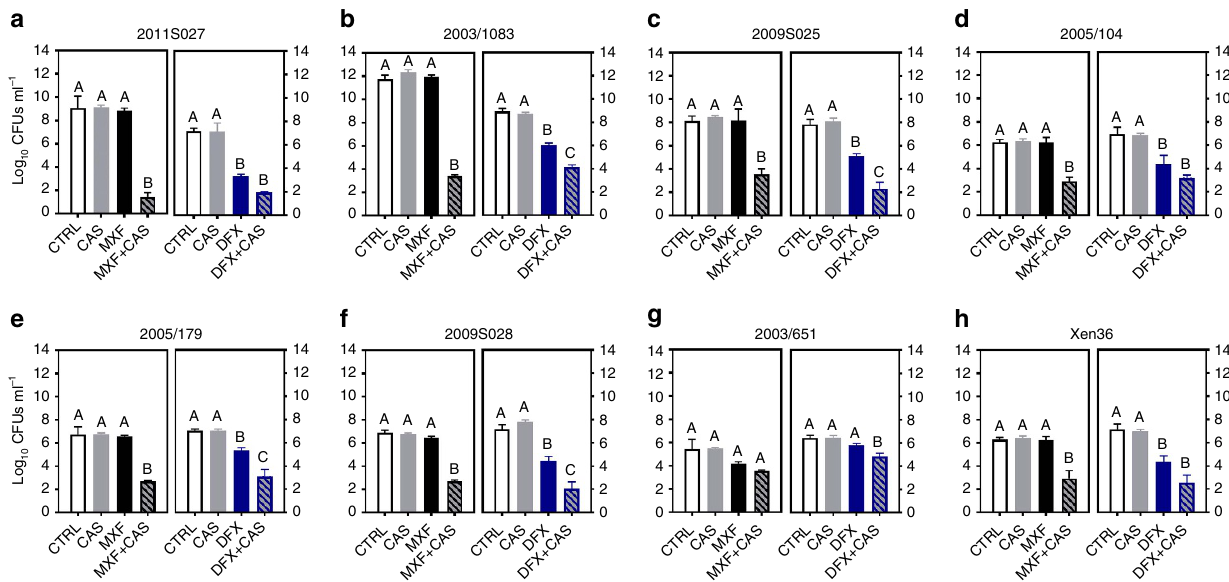
Figure 3 | Effect of caspofungin fluoroquinolones used alone or in combination on biofilms grown in catheters in vitro . Biofilms grown in catheters for clinical isolates ( a – g ) and the bioluminescent strain Xen36 ( h ) during 24h were exposed to caspofungin (CAS; 40mgl (cid:2) 1 ), fluoroquinolones alone (10mgl (cid:2) 1 ) or combined with 40mgl (cid:2) 1 CAS. In each graph, the left panel shows data obtained with moxifloxacin (MXF; black) and the right panel, data obtained with delafloxacin (DFX; blue) and matching controls for each strain. The graphs show the number of CFU (in log 10 units) recovered from catheters after 48h of incubation in the absence (control (CTRL)) or in the presence of the drugs. Data are means ± s.d. for three catheters. Statistical analysis: bars with different letters show data that significantly different from one another ( P o 0.01; one- way ANOVA with Tukey post-hoc